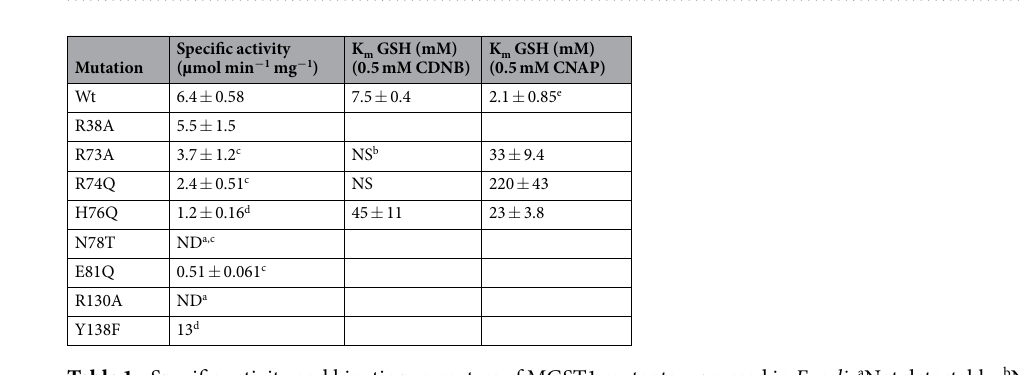
Table 1. Specific activity and kinetic parameters of MGST1 mutants expressed in E. coli. a Not detectable, b